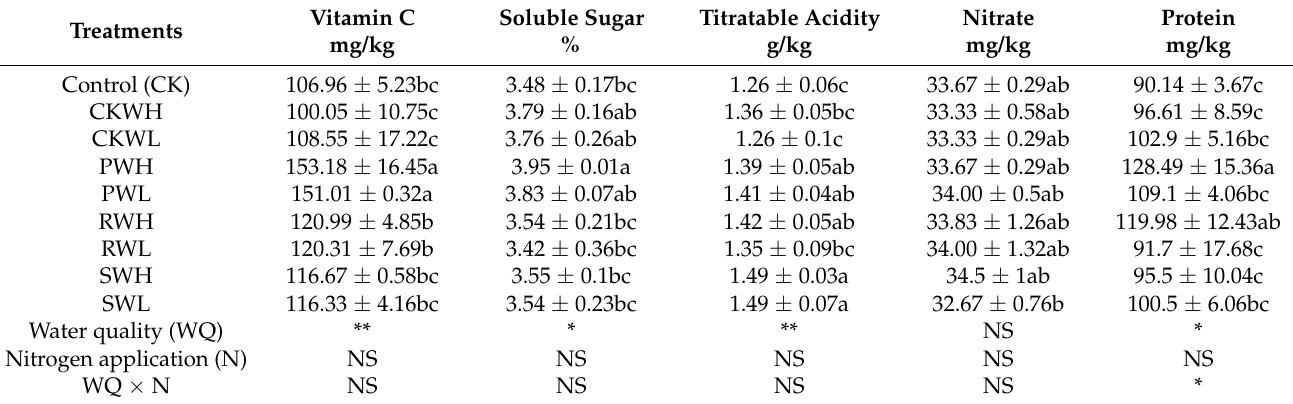
Table 8. Effects of different irrigation treatments on the quality of